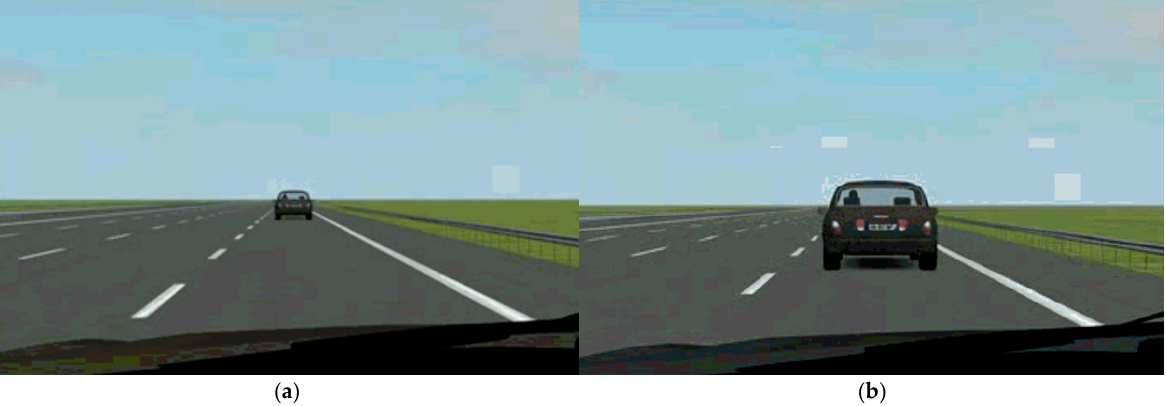
Figure 5. Two different stimulation scenarios in fMRI experiment: ( a ) non-critical takeover; ( b ) crit- ical takeover.